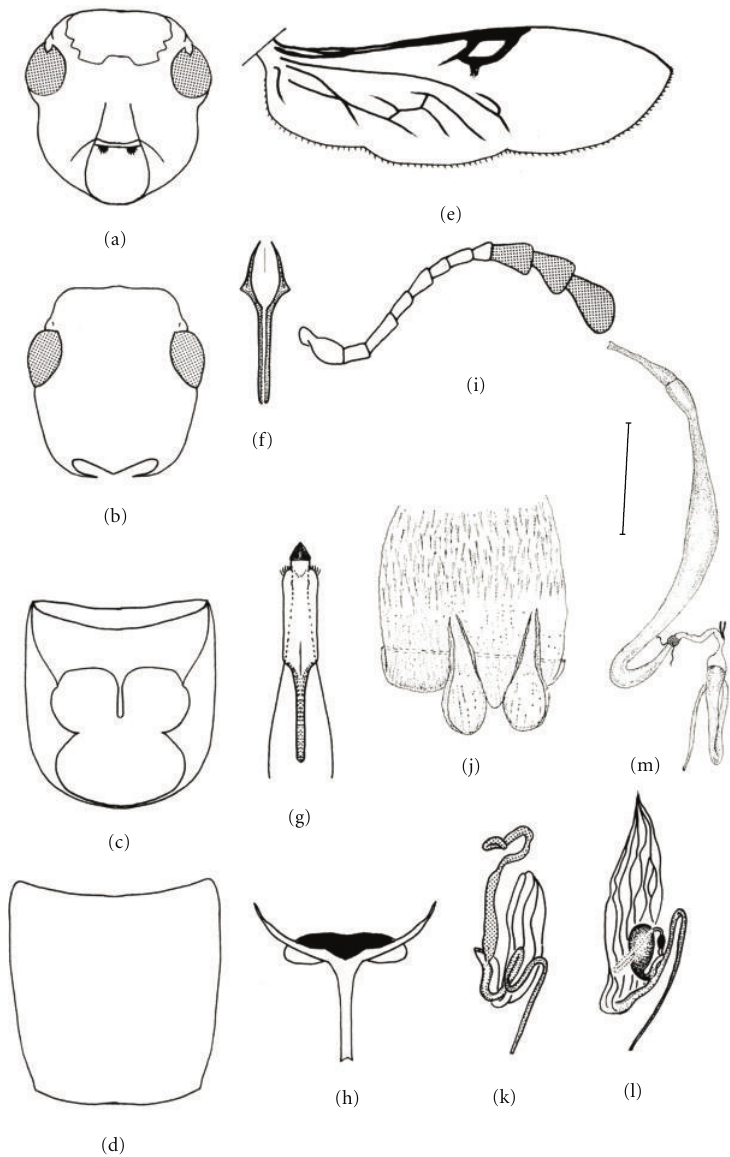
Figure 18: Various organs of Tarsostenus univittatus . (a, b) Head ((a) ventral, (b) dorsal). (c, d) Pronotum ((c) ventral, (d) dorsal). (e) Metathoracic wing. (f) Spiculum. (g) Aedeagus. (h) Metendosternite. (i) Antenna. (j) Stomodaeal valve (interior view). (k) Male mesodermal reproductive organs. (l) Female mesodermal reproductive organs. (m) Alimentary canal.